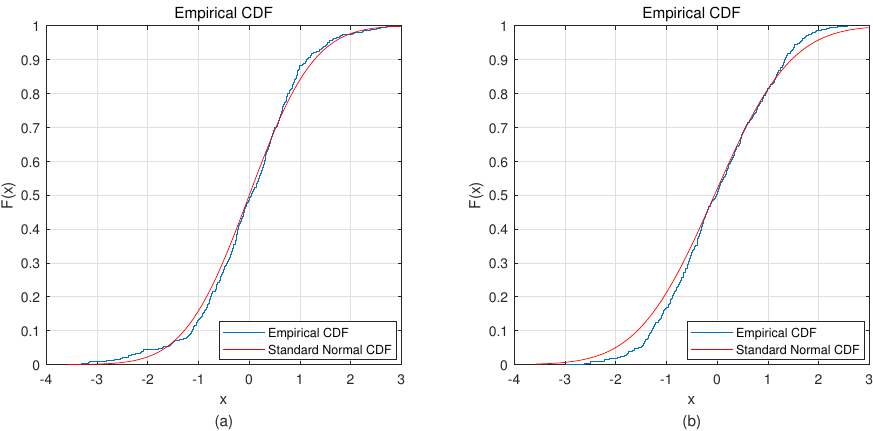
Figure 7. Distribution of both datasets. ( a ) is the distribution of BCI competition IV dataset 2b; ( b ) is the distribution of our own dataset